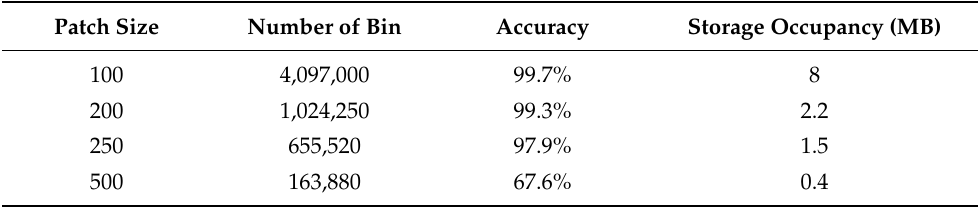
Table 6. Accuracy and size of CLBP fingerprints to vary of patch